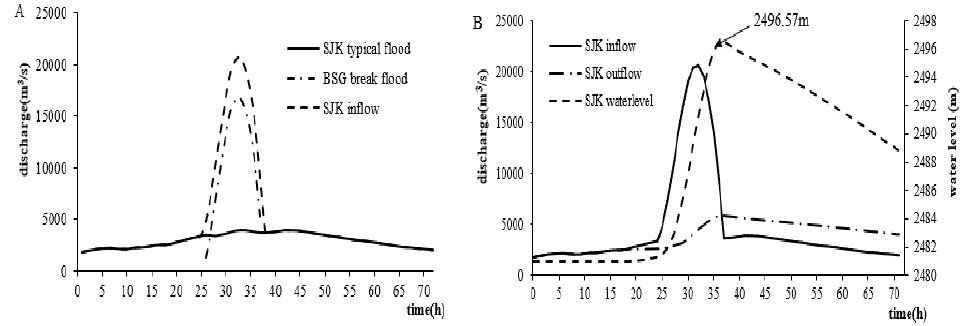
Figure 17. ( A ) The BSG break flood encounters SJK typical flood; ( B ) the regulated flood progress of SJK.